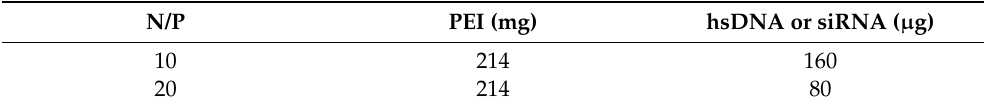
Table 2. Weight ratios ( w / w ) between PEI and nucleic acid used to synthetize polymeric particles with different N/P